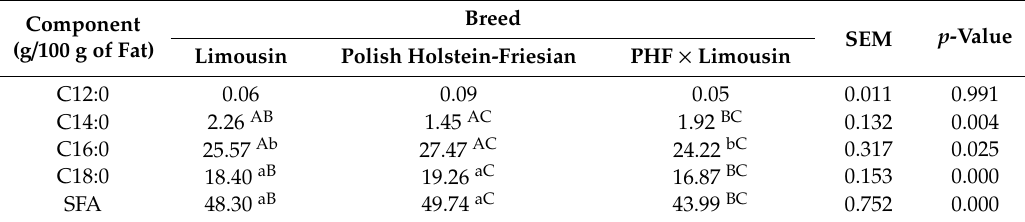
Table 4. The influence of breed on the formation of the saturated fatty acid composition of muscle tissue.